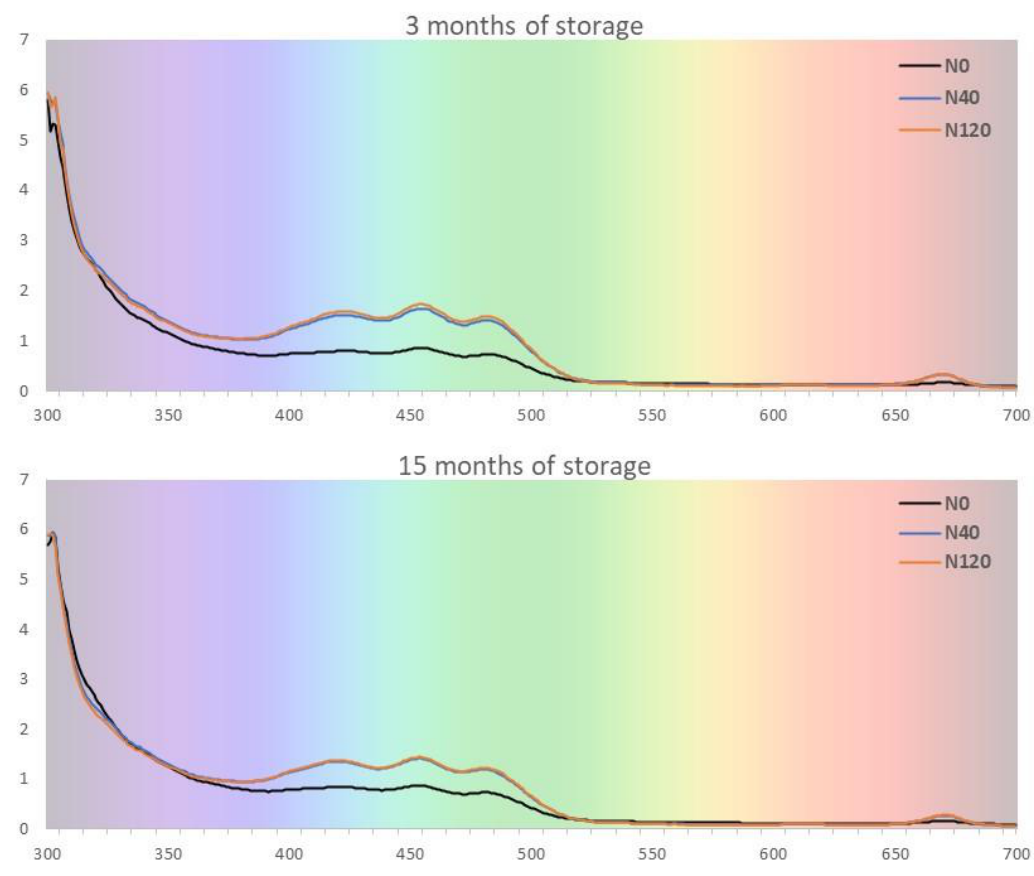
Figure 3. Absorption spectra from olive oil after 3 and 15 months of storage from olives harvested in 2018 and olive trees supplied with 0 (N0), 40 (N40) and 120 (N120) kg ha −1 of N. Table 4. Olive oil quality indices (samples from the harvest of 2018 after 3 and 15 months of storage) from olive trees supplied with 0 (N0), 40 (N40) and 120 (N120) kg ha −1 of N.